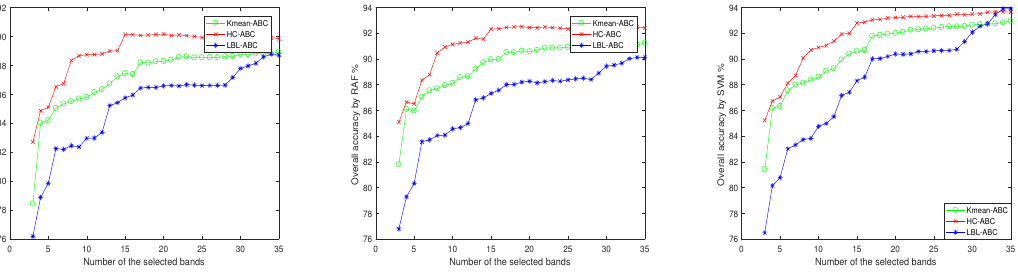
Figure 17. The OA values obtained by K-mean-ABC, HC-ABC, and LBL-ABC on